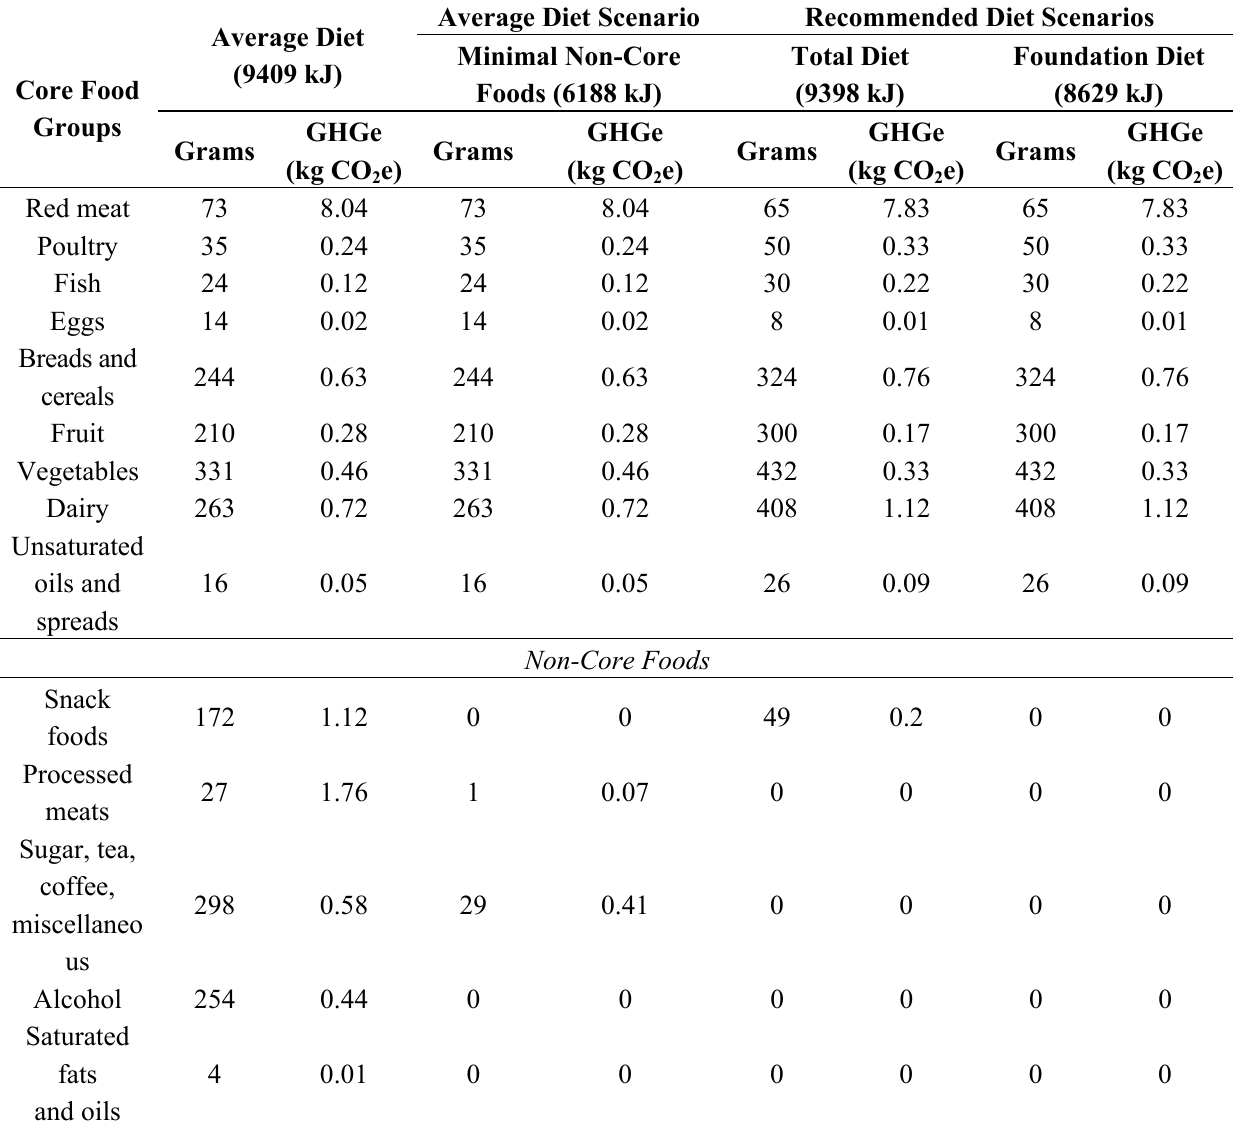
Table 1. Summary of diets and greenhouse gas emissions (GHGe) 1 for food groups for the diet scenarios 2 , as an average consumption per person per